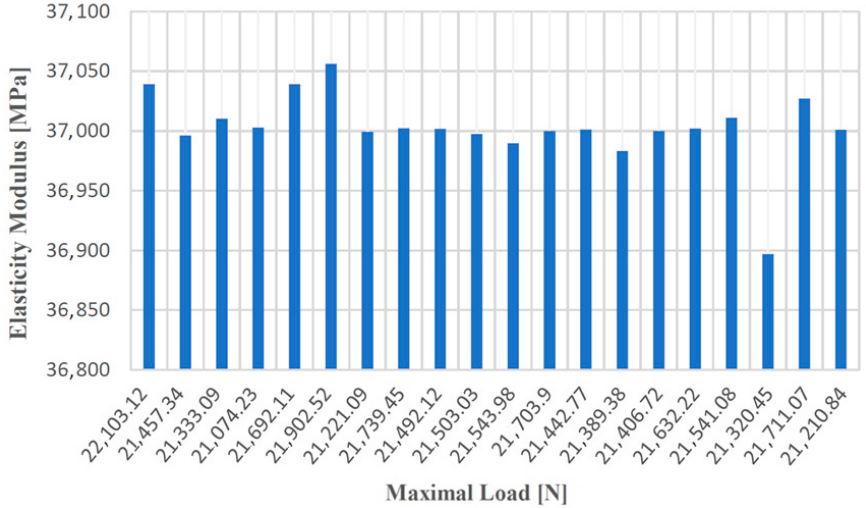
Figure 11. Values of the modulus of elasticity according to the maximum forces applied to the 20 samples made of cast iron with lamellar graphite type EN-GJL-250. Table 2. Results of tensile tests on EN-GJS-400-15 spheroidal graphite cast iron testing samples.